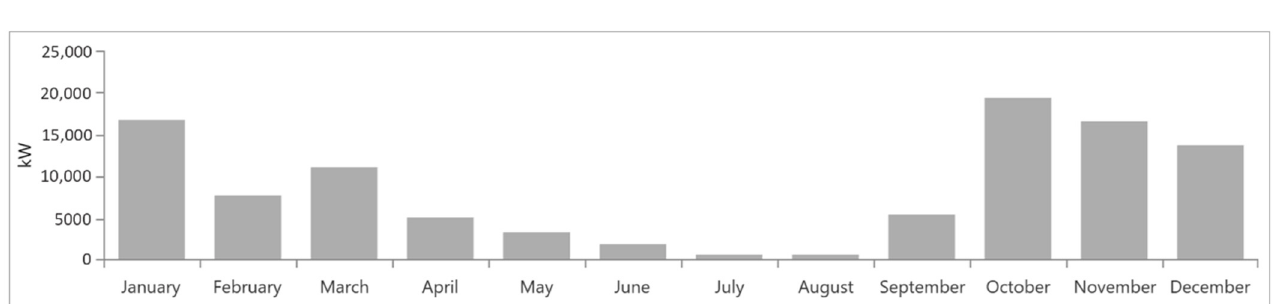
Figure 9. Monthly average electric power consumption by electrolyzer.